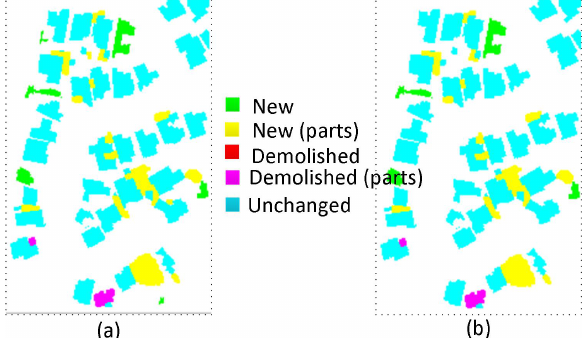
Figure 5: Building detection examples: with (left) and without (right) the improvement in Section 3. Row 1 from Scene 2 and Rows 2 & 3 from Scene 3.